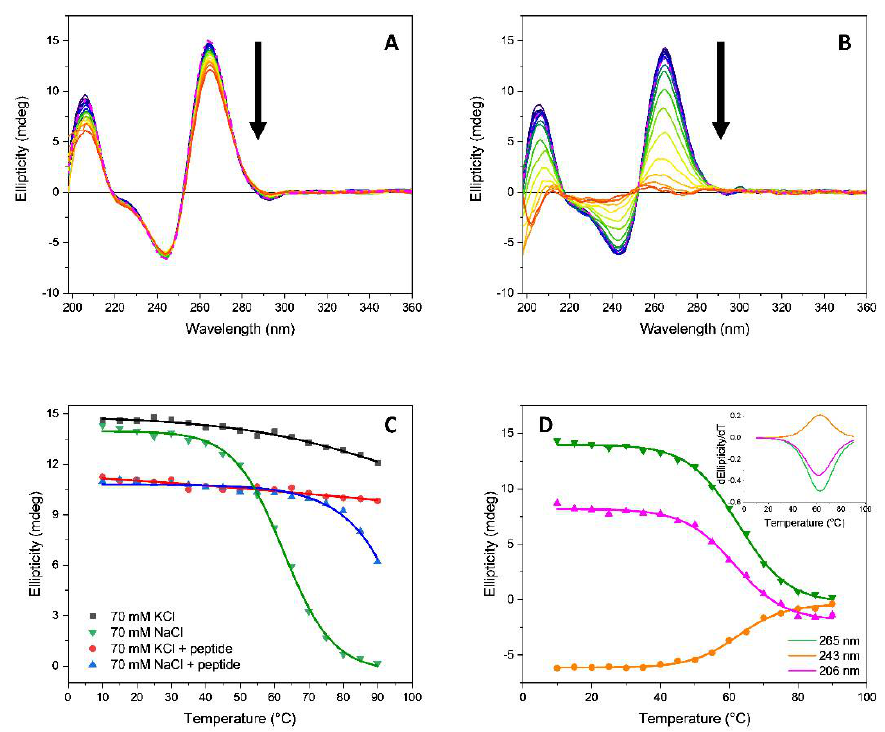
Figure 11. Influence of temperature on the SRCD spectra of T95-2T (13.5 µ M) in 10 mM Tris-HCl buffer, pH 7.4, containing 70 mM ( A ) potassium or ( B ) sodium ions. The temperature varied from 10 to 90 °C. The dashed line represents the oligonucleotide cooled to 20 °C after heating to 90 °C. The arrows represent the direction of the spectral change as the temperature is increased; ( C ) SRCD-melting curves in sodium or potassium ions, and in the absence or presence of 2.2 equivalents of Rhau25 peptide; ( D ) Melting curves of T95-2T in 10 mM Tris-HCl buffer, pH 7.4, containing 70 mM sodium ions at 206 nm (magenta), 243 nm (orange), and 265 nm (green) with insert for the corresponding first derivatives.